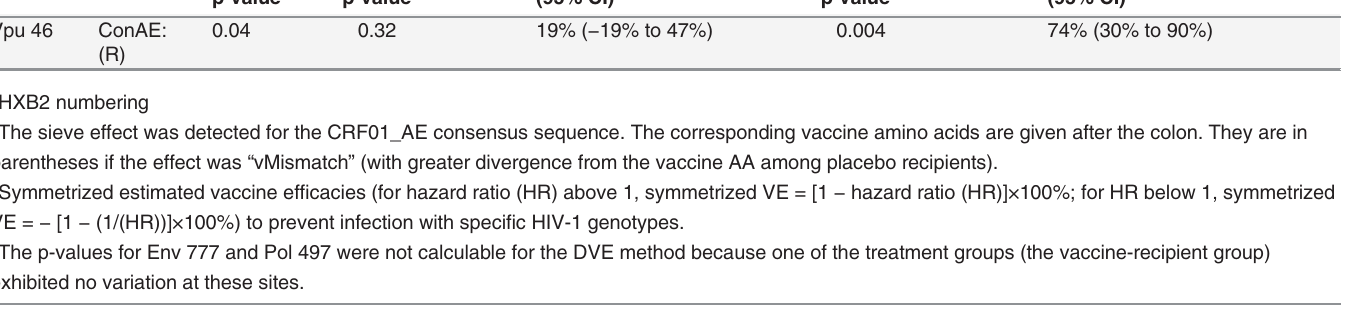
Table 5. Immunologically relevant subsets of sites.